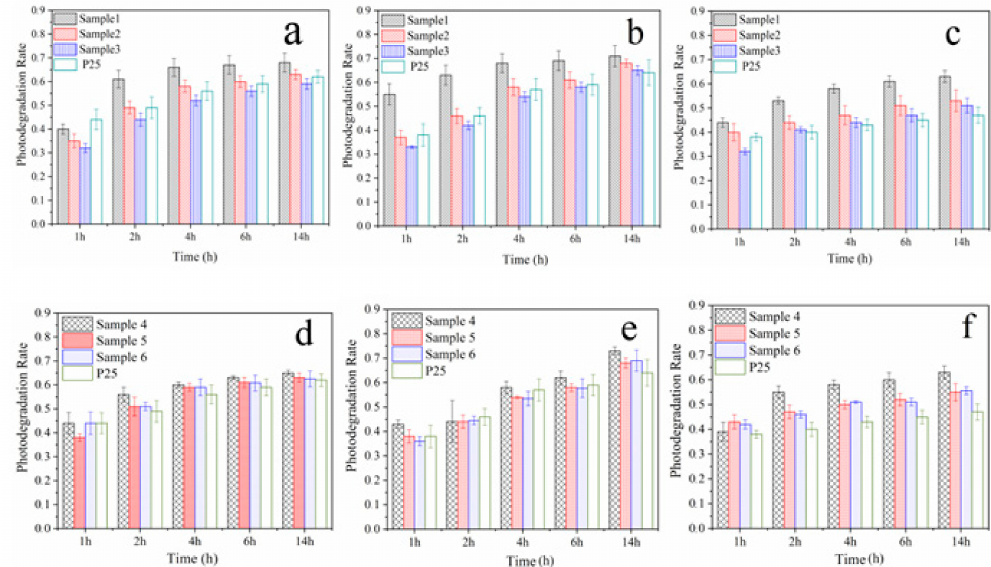
Figure 3. SEM images of harden cement pastes ( a ) and samples treated with Samples 1–3 ( b – d ) and P25 ( e ).